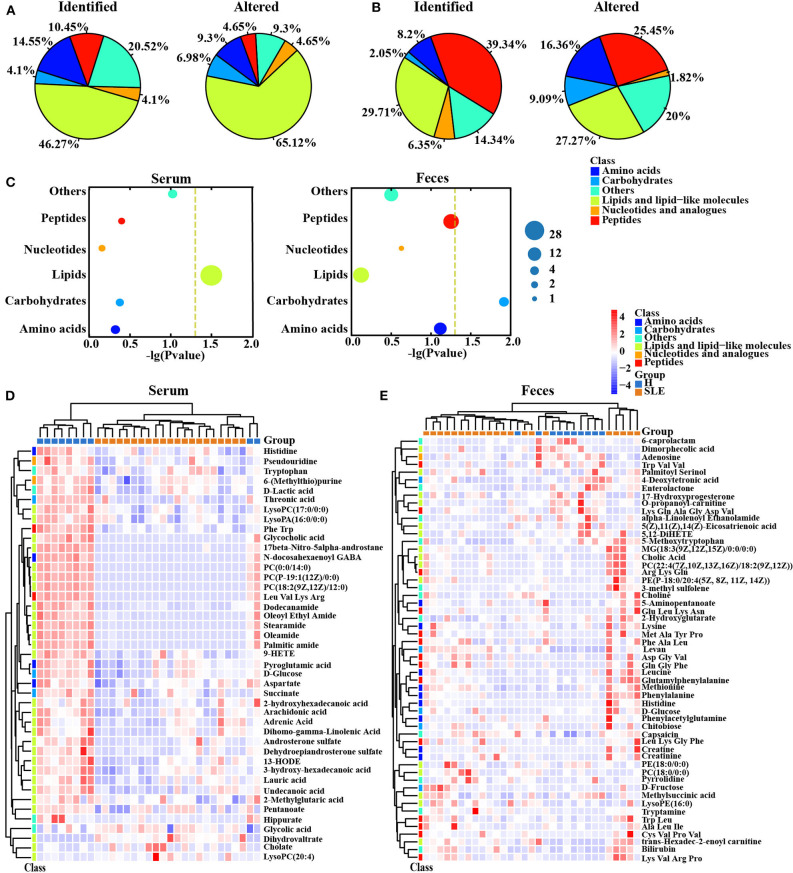
Serum and feces metabolic profiling in SLE patients. (A) Pie graph of the metabolite class composition of identified and significantly altered metabolites in SLE patients according to the number of metabolites in serum. Left, identified serum metabolite class composition; Right, significantly altered serum metabolite class composition. (B) Pie graph of the metabolite class composition of identified and significantly altered metabolites in SLE patients according to the number of metabolites in feces. Left, identified fecal metabolite class composition; Right, significantly altered fecal metabolite class composition. (C) Enrichment analysis of significantly changed metabolite class in serum and feces samples. The size of each dot represents the number of metabolites significantly changed in the corresponding metabolite class. The dashed yellow line represents the significant level (p = 0.05). (D) Significantly changed metabolite heatmap in serum samples. The abundance of each metabolite is normalized by Z score normalization. Metabolite class is shown in the left of the heatmap. (E) Heatmap for significantly changed metabolites in feces samples. The abundance of each metabolite is normalized by Z score normalization. Metabolite class is shown in the left of the heatmap.